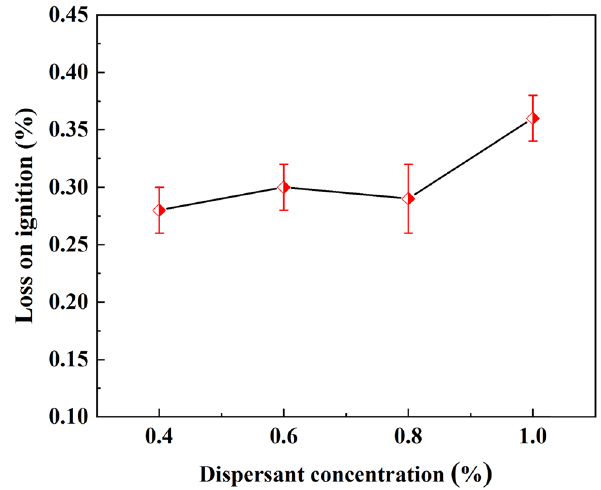
Figure 7: LOI of the silver powder prepared with di ff erent dispersant